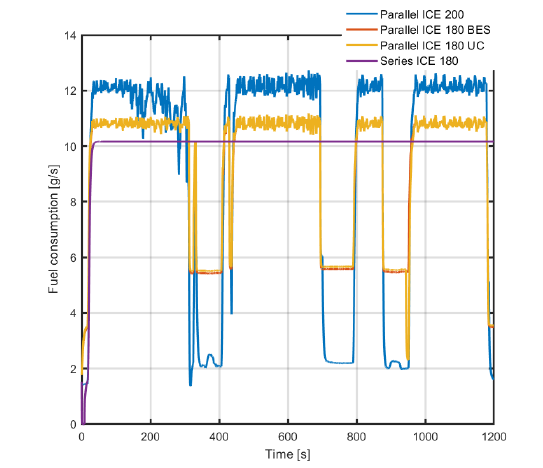
Figure 16: Fuel consumption of various hybridization options of the excavator